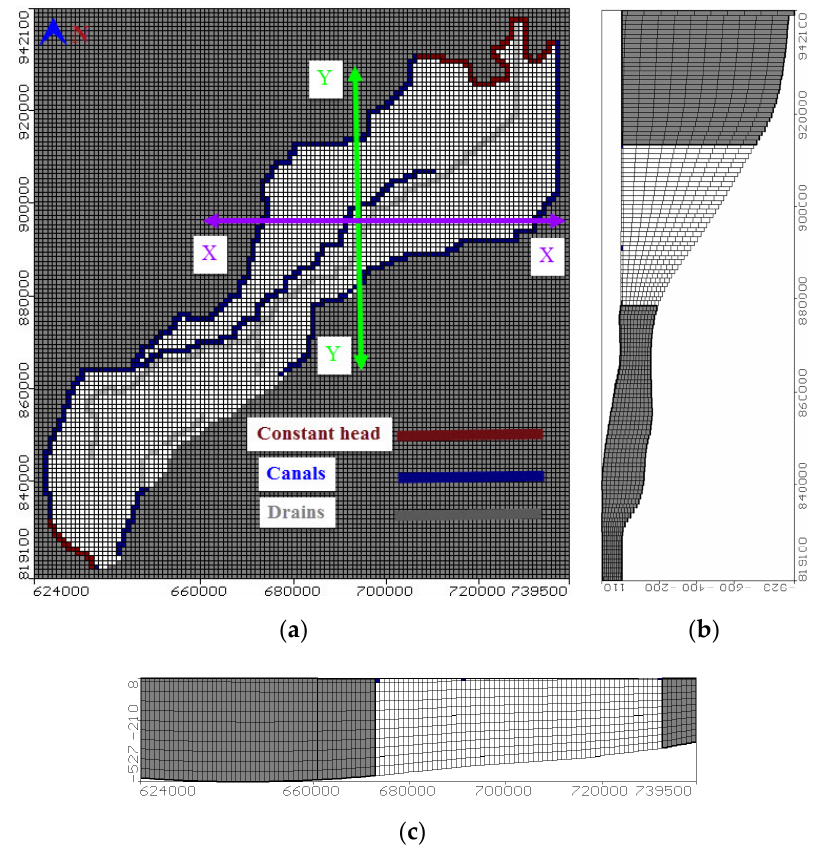
Figure 3. Numerical model geometry and boundary condition ( a ) a real view, ( b ) X-direction from East to West and ( c ) Y-direction from North to South.